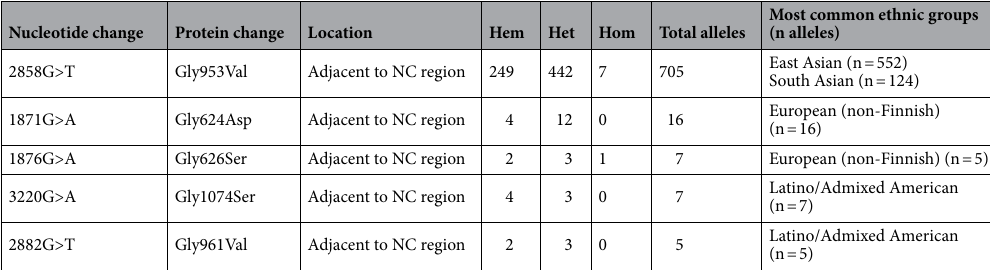
Table 5. The five most frequently found COL4A5 Gly missense variants reported in gnomAD. Hem, hemizygotes; Het, heterozygotes; Hom, homozygotes; NC,